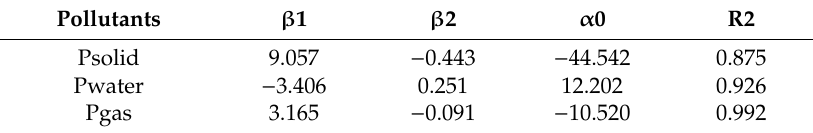
Table 5. The fitting results of the environmental Kuznets curve (EKC)